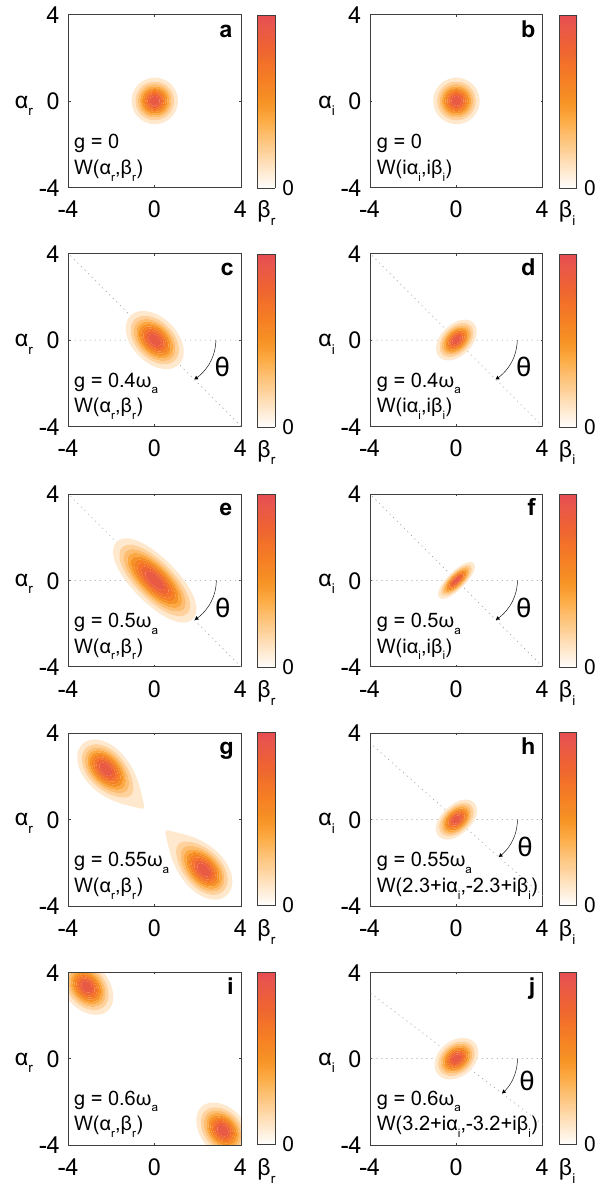
ω a . 2 6 64 and ω b Figure 2. Wavefunctions W (α , β) of the ground states of the Dicke model for N = = = 0 , ( c, d ) g 0.4 ω a , ( e, f ) g 0.5 ω a , ( g, h ) g 0.55 ω a , and The photon–atom coupling strength is ( a, b ) g = = = = 0.6 ω a . Panels ( a, c, e, g, i ) show W (α r , β r ) and ( b, d, f ) show W ( i α i , i β i ) . Panels ( h ) and ( j ) show ( i, j ) g = 2.3 and 3.2 are the peak positions at Panels g i α i , 2.3 i β i ) and W ( 3.2 i α i , 3.2 i β i ) , where W ( 2.3 ± ± + − + + − + β r and α i β i planes, 0.5 ω a , W (α , β) is anti-squeezed and squeezed in the α r and i, respectively. For 0 < g ≤ − − 0.55 ω a and 0.6 ω a , W (α , β) gets two peaks in the 0.25 π . For g respectively, along the direction of θ = = − α r β r plane and becomes less squeezed than for g β i plane. Parameters in the numerical 0.5 ω a in the α i = − − calculations are shown in “Methods”. W (α , β) is normalized to each maximum